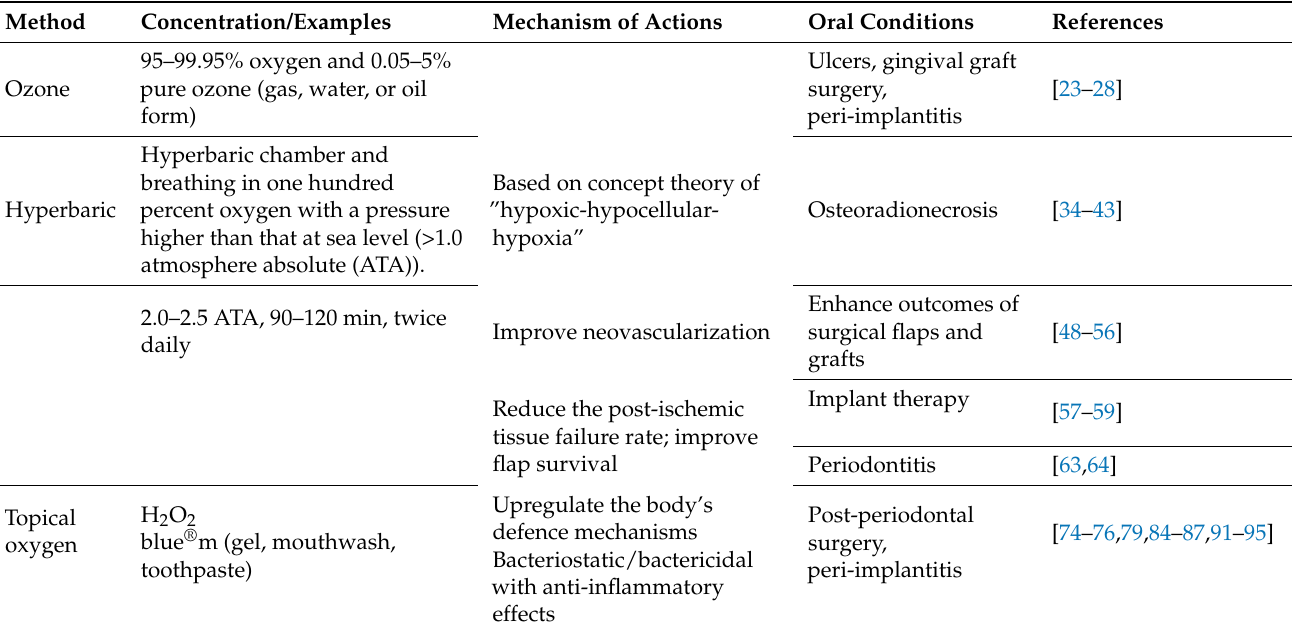
Table 1. Summary of the use of oxygen therapy to induce angiogenesis in oral would